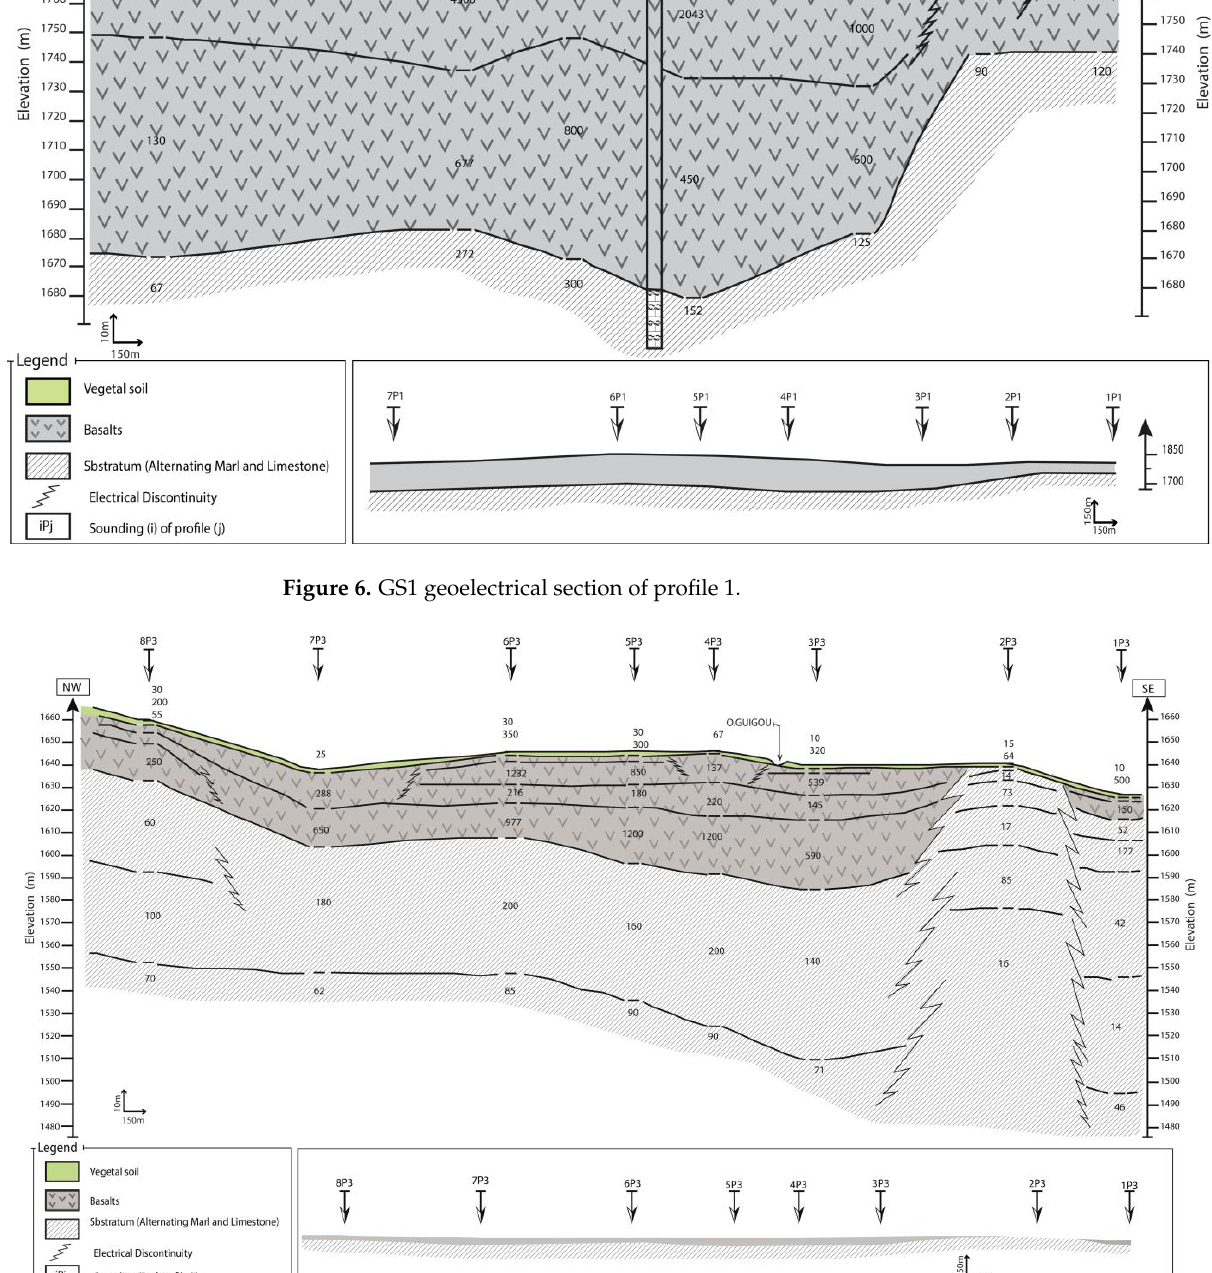
Figure 7 . GS2 geoelectrical section of profile 3.